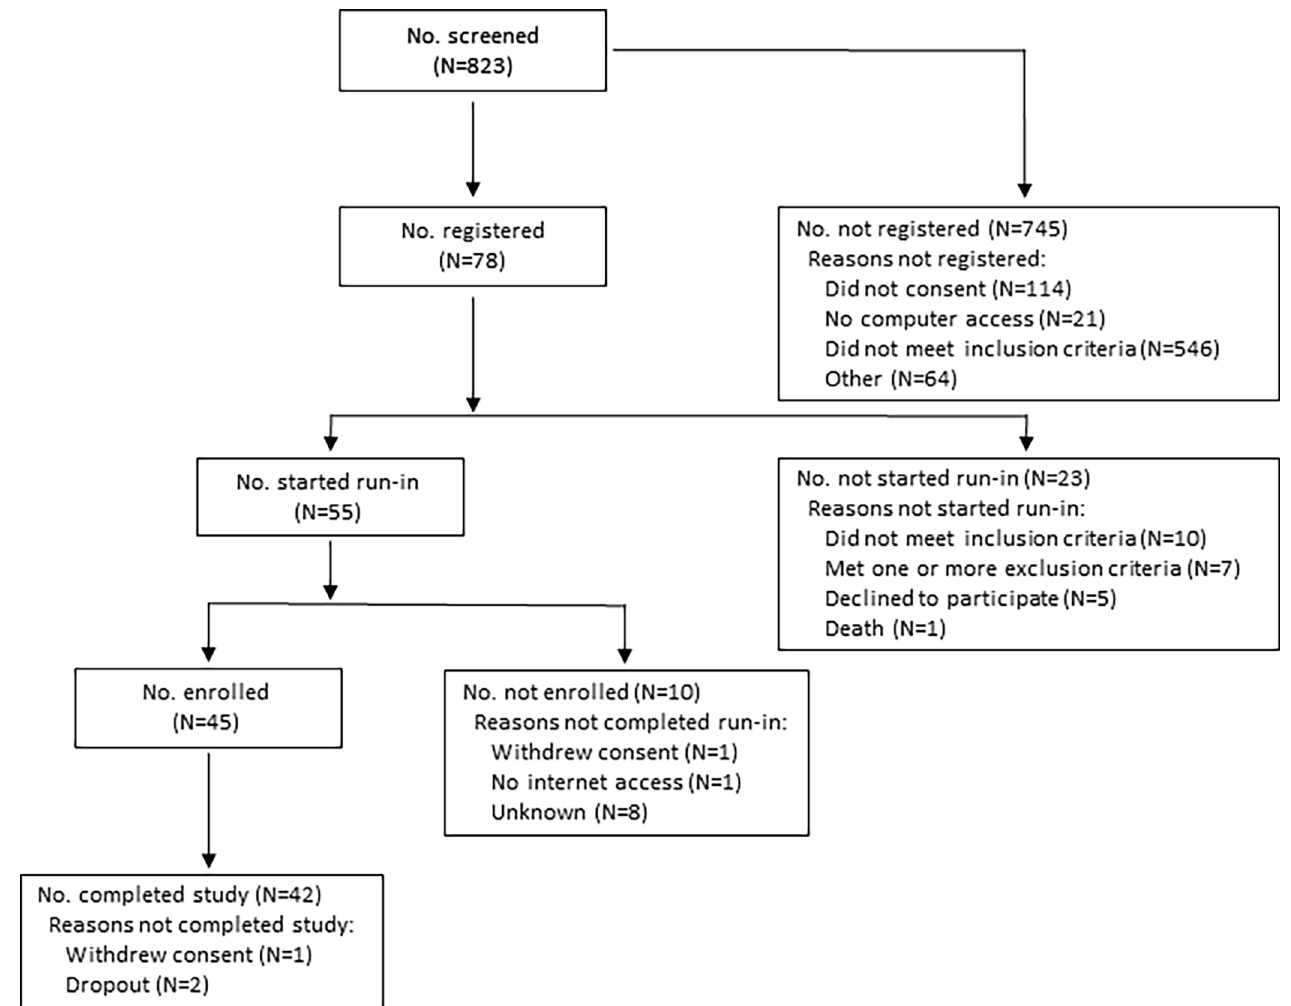
Fig 1. Flowchart for the GLUMIT-DG study. This figure shows the Flowchart for patient recruitment for the GLUMIT-DG study, which follows a non- randomized trial design. A TREND checklist accompanies this Flowchart as the S1 File in the Supplemental Information